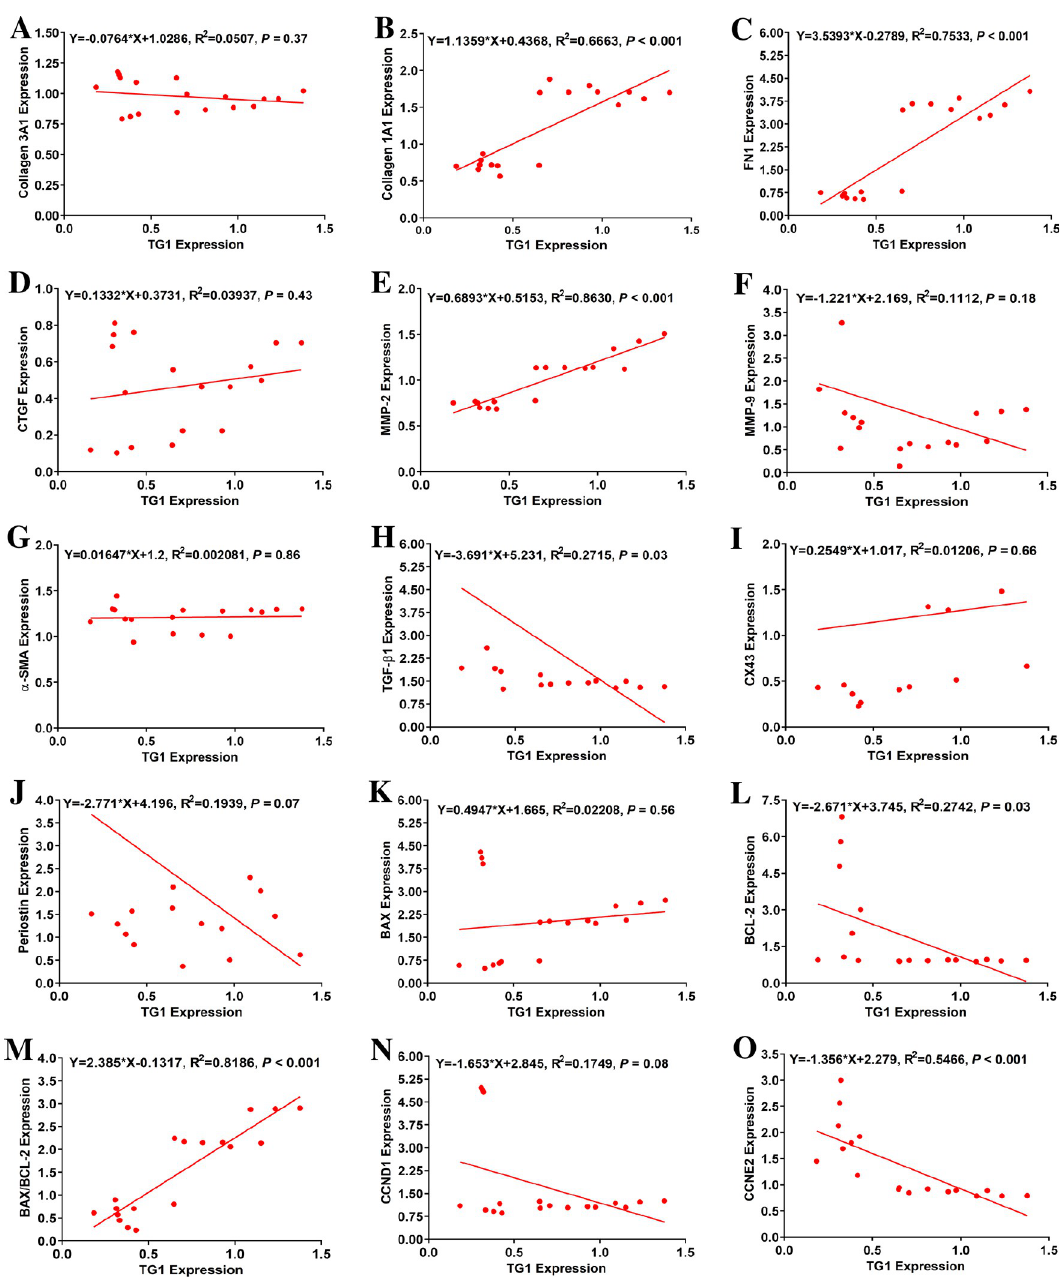
Fig 5. Transglutaminase 1 (TG1) mRNA expression was strongly correlated with mRNA expression of collagen 1A1 (COL 1A1), fibronectin 1 (FN 1), matrix metalloproteinase-2 (MMP-2), cyclin E2 (CCNE 2) and BCL-2-associate X protein (BAX)/B-cell lymphoma 2 (BCL-2) ratio. Correlations between mRNA levels of TG1 following individual knockdown and mRNA levels of profibrotic, proliferation and apoptotic markers in neonatal rat ventricular fibroblasts (n = 18): (A) collagen 3A1 (COL 3A1), (B) COL 1A1, (C) fibronectin 1 (FN 1), (D) connective tissue growth factor (CTGF), (E) matrix metalloproteinase-2 (MMP-2), (F) MMP-9, (G) α -smooth muscle actin ( α -SMA), (H) transforming growth factor β 1 (TGF- β 1), (I) connexin 43 (CX 43), (J) periostin, (K) BAX, (L) BCL-2, (M) BAX/BCL-2 ratio, (N) cyclin D1 (CCND 1), and (O) cyclin E2 (CCNE 2). R 2 : Correlation coefficient; in the equations, (X) and (Y) respectively denote TG1 expression and expression of the profibrotic, proliferation or apoptotic